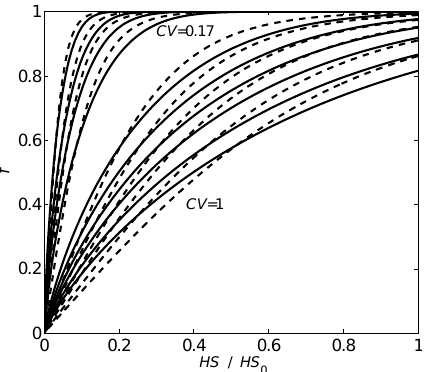
Figure 9. Snow-cover depletion curves derived assuming normally distributed snow depth and homogeneous melt via Eq. (4) as func- tion of mean HS normalized with the peak of winter mean snow depth HS 0 (indicated by the subscript 0) (solid lines). Dashed lines represent parameterized fractional SCA f via Eq. (7). Coefficient of variations CV vary between 0.06 (upper left) and 1 (lowest one).